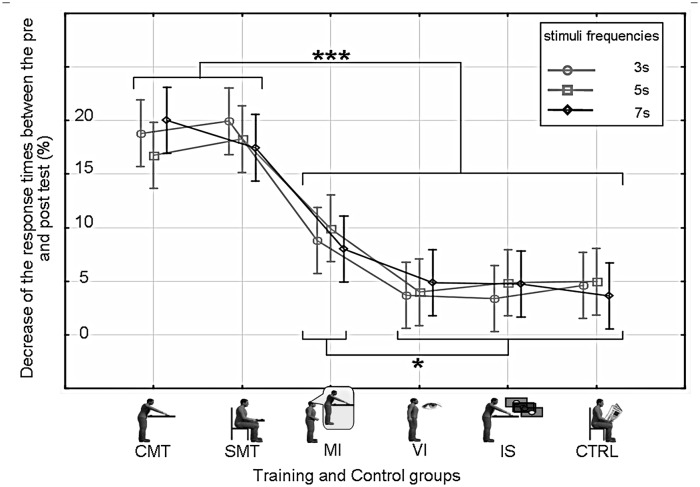
Percentage decrease in the response time (mean ± std) in the post-training test phase when compared to that in the pre-training phase.Gain ratios are reported for all the experimental groups (x-axis) and every test frequency (3s with rounds, 5s with squares and 7s with diamonds). *p<0.05, ***p<0.001